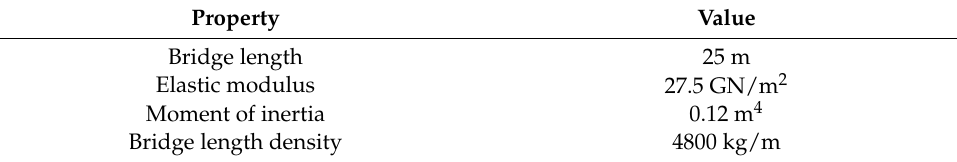
Table 1. Beam Properties.